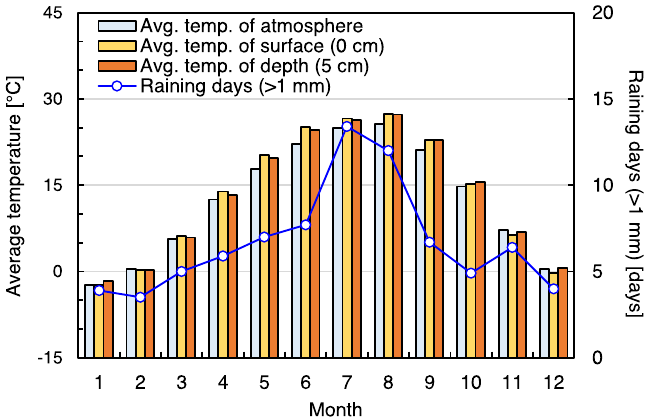
Figure 1. Average air and surface temperatures and frequency of rainfall in South Korea (Seoul) from 1981 to 2010. Data from Korea Meteorological Administration (https:// www. weath er. go.